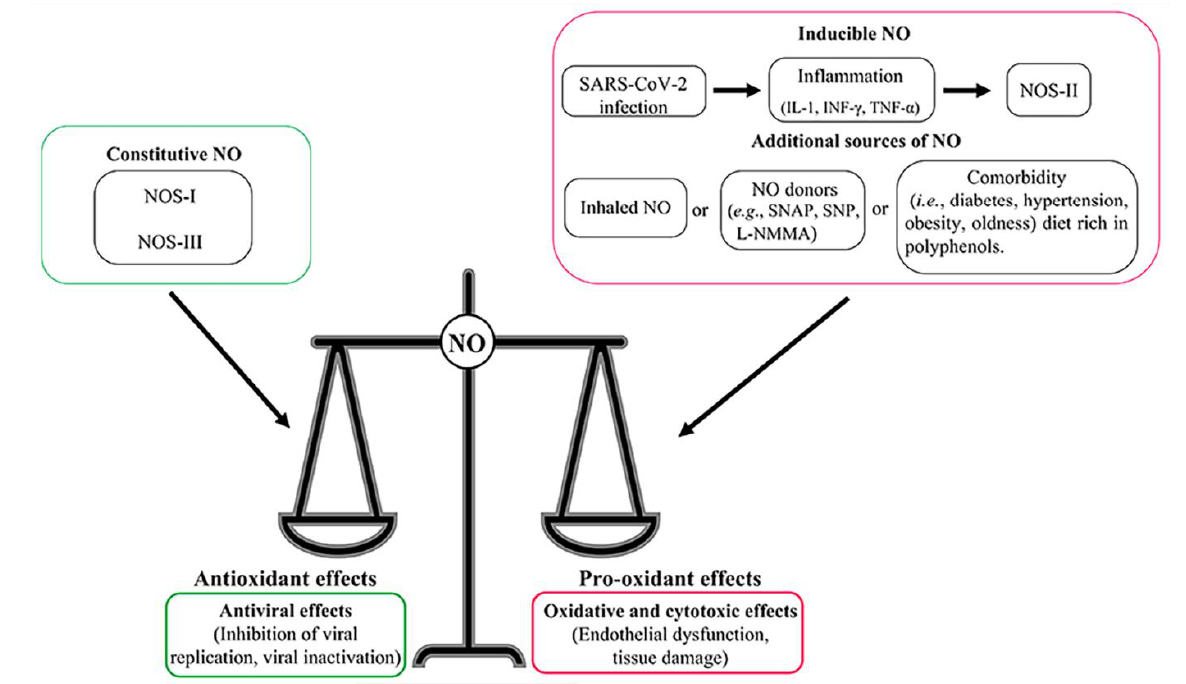
Figure 3. Role of NO during the viral infection. Constitutive NO exerts an antiviral activity controlling infection whereas the inducible and exogenous NO contributes to inflammation and pro-oxidants effects (e.g., tissue damage and cell death).